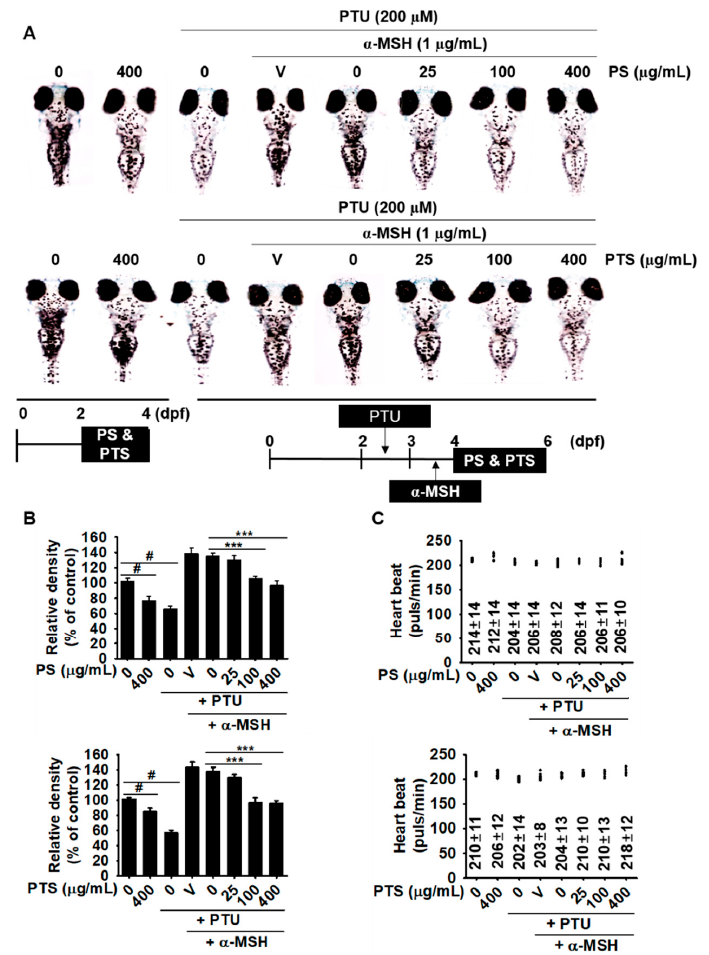
Figure 5. PS and PTS inhibit melanin synthesis in zebrafish larvae. ( A and B ) Zebrafish larvae at 2 dpf were treated with PS and PTS (400 μ g/mL) for 48 h, and images were collected (left two zebrafish larvae, top for PS and bottom for PTS). Additionally, 2 dpf zebrafish larvae ( n = 20) were treated with PTU (200 μ M) for 24 h, and the medium was replaced with α‐ MSH (1 μ g/mL) for another 24 h. Next, the larvae were treated with the indicated concentrations of PS or PTS for 48 h. The effects of PS and PTS on pigmentation in zebrafish larvae were observed under an Olympus microscope (40×). ( B ) Relative density was calculated by the Image J software. ( C ) Average heart rate of zebrafish larvae ( n = 20) was measured to assess the toxicity of PS and PTS. Data are reported as the mean ± SEM. # p < 0.05 vs. untreated group; *** p < 0.001 vs. α‐ MSH ‐ stimulated group. V, vehicle control (0.05% DMSO).